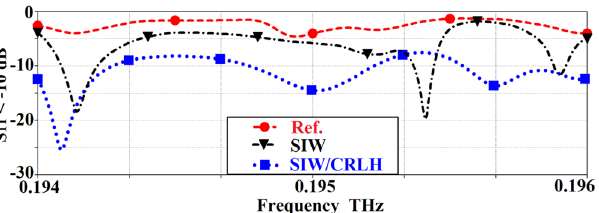
Figure 9. Simulated reflection-coefficient response of the reference, SIW-loaded, and SIW-loaded MTM (CRLH) antennas.